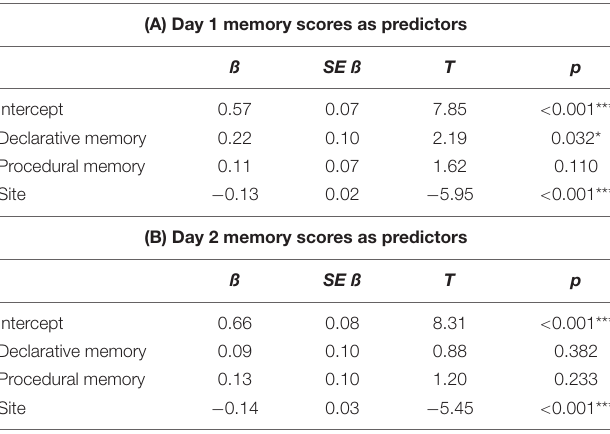
TABLE 4 | Results for multiple regression analysis of nonword repetition (NWR)